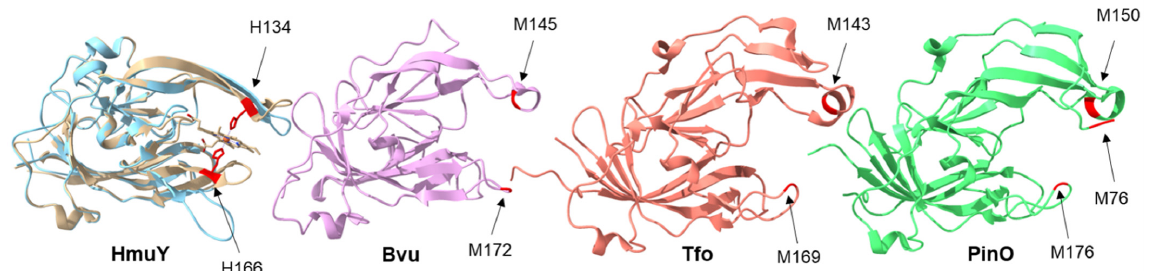
Figure 2. Comparison of three-dimensional protein structures of best-characterized HmuY family proteins. Tertiary structures of proteins determined by X-ray crystallography shown. P. gingivalis apo-HmuY (blue) (PDB ID: 6EWM) [26] and HmuY in complex with heme (beige) (PDB ID: 3H8T) [29], B. vulgatus Bvu (purple) (PDB ID:3U22), T. forsythia Tfo (coral) (PDB ID: 6EU8) [26], and P. intermedia PinO (green) (PDB ID: 6R2H) [27]. Amino acid residues coordinating heme iron, identified by site-directed mutagenesis, are shown in red and indicated with arrows. Three-dimensional protein structures visualized using UCFS Chimera tool [34].